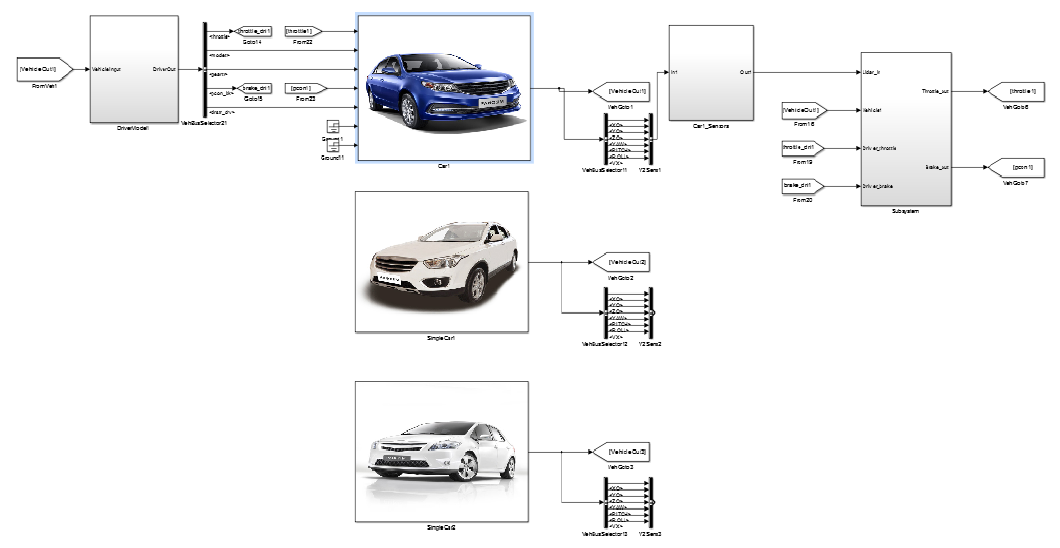
Figure 26. Simulink model file of AEB decision algorithm based on MATLAB and PanoSim software.